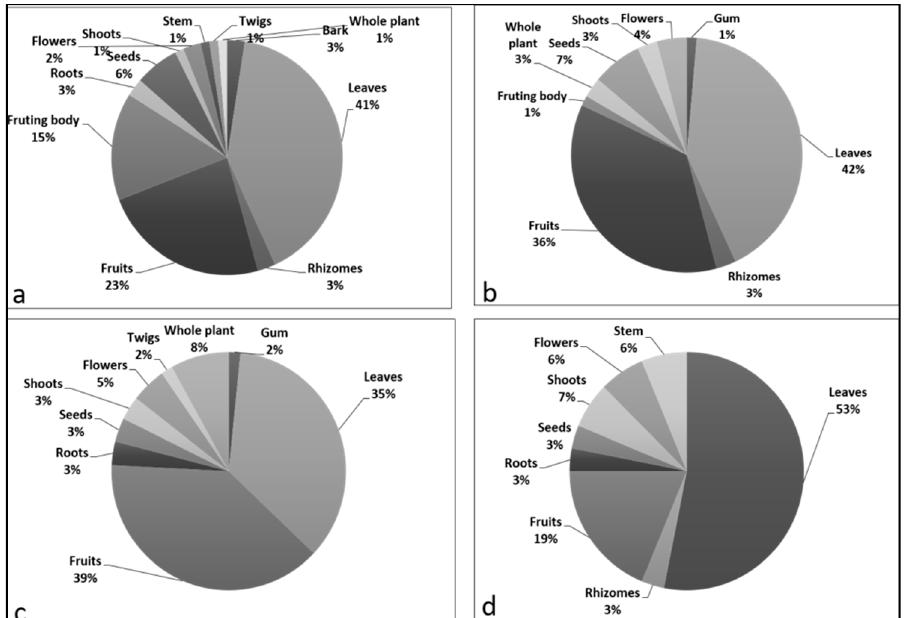
Figure 6. Comparative percentage of different plant parts used in ( a ) Kashmir ( b ) Jammu ( c ) Azad Kashmir ( d ) Ladakh region.